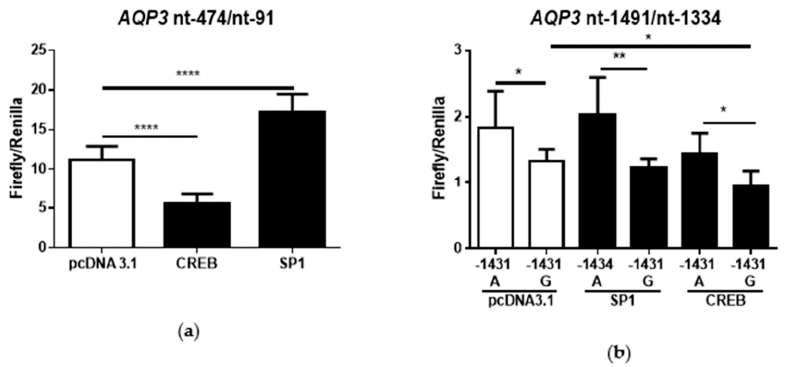
Figure 2. Luciferase assay showing AQP3 promoter activity (mean ± SD) in Caco-2 cells after 2 overexpression of cAMP response element-binding protein (CREB) and specificity protein 1 (SP1). Promoter activity of the nt-91 / nt-474 promoter construct ( a ) and the nt-1334 / nt-1491 ( b ) was examined after co-transfection with control vector (pcDNA3.1), CREB-pcDNA3.1 (CREB), or SP1-pcDNA3.1 (SP1) vectors ( n = 6). * p ≤ 0.05; ** p ≤ 0.01; **** p ≤